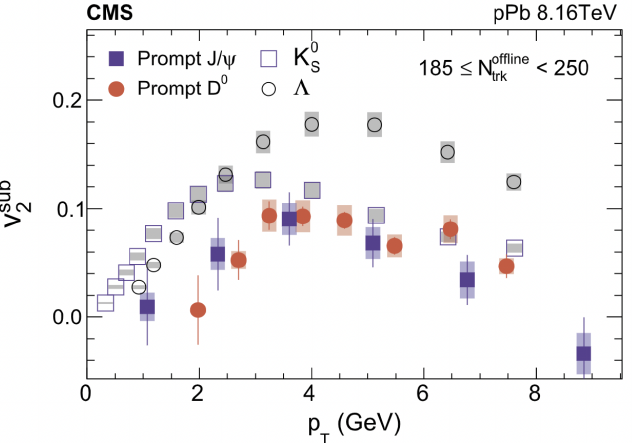
Figure 17. The elliptic flow v 2 is shown as a function of p T for prompt D 0 (red data points) and J / ψ (blue data points) in p + Pb collisions [83]. Reprinted with permission from